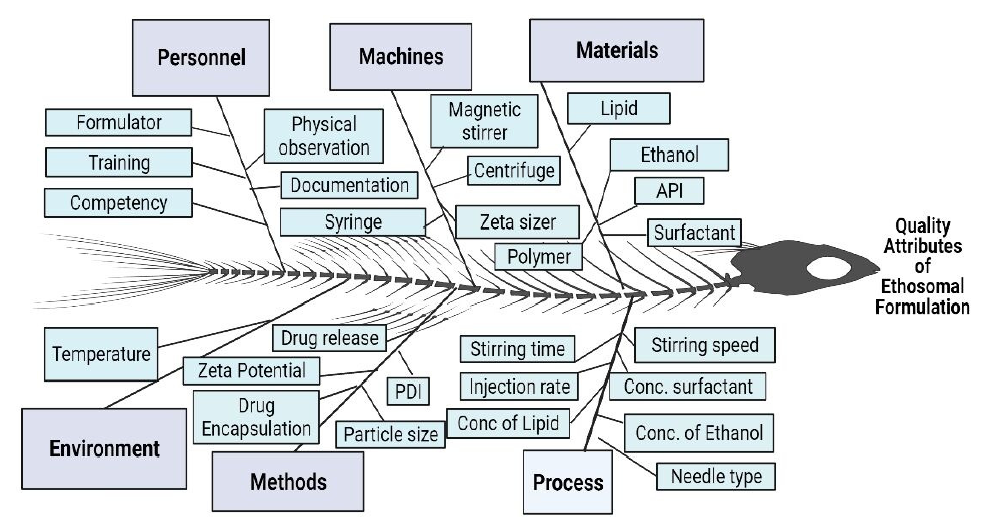
Figure 2. Ishikawa diagram explaining the key elements responsible for the quality attributes of the ethosomal gel.